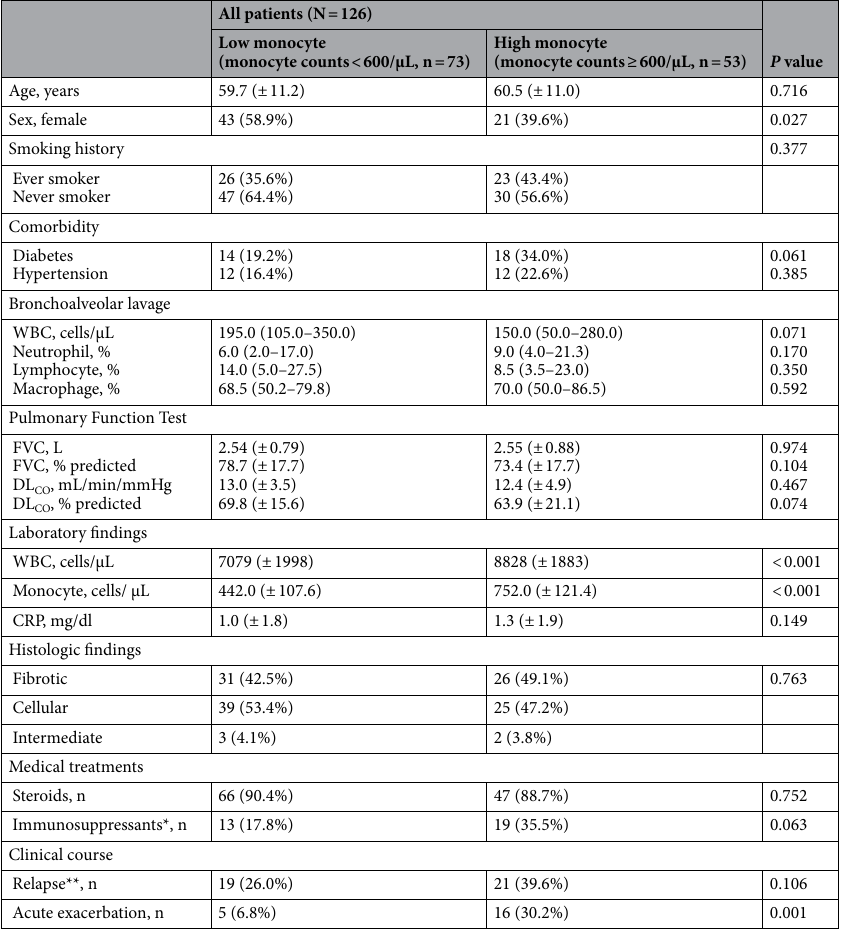
Table 1. Characteristics of patients according to blood monocyte counts. Data are expressed as the mean (± standard deviation), median (interquartile range), or counts (%). FVC, forced vital capacity; DL CO , diffusing capacity of the lung for carbon monoxide; WBC, white blood cells; CRP, C-reactive protein. NSIP, nonspecific interstitial pneumonia. *Medications including azathioprine, mycophenolate mofetil, or tacrolimus. **Deterioration of clinical course including lung function, symptoms, or radiologic findings and re-prescribed steroids with or without